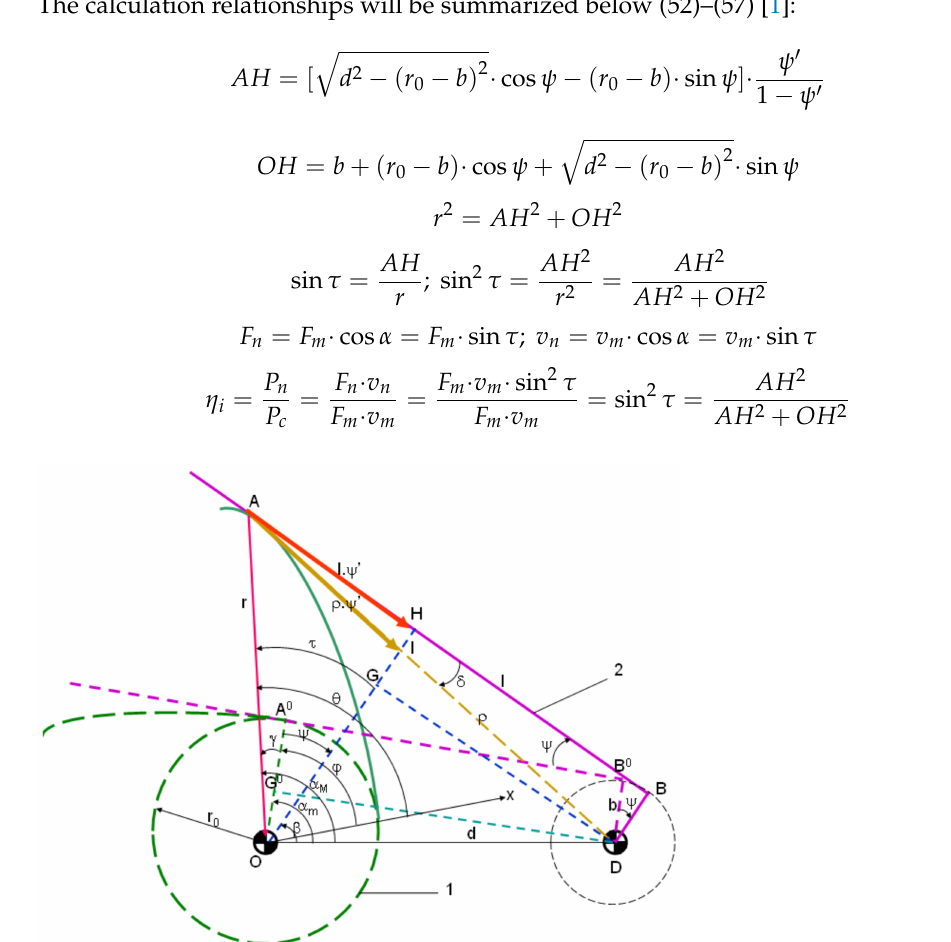
Figure 8. A mechanism with rotating cam and rotating adept (flat